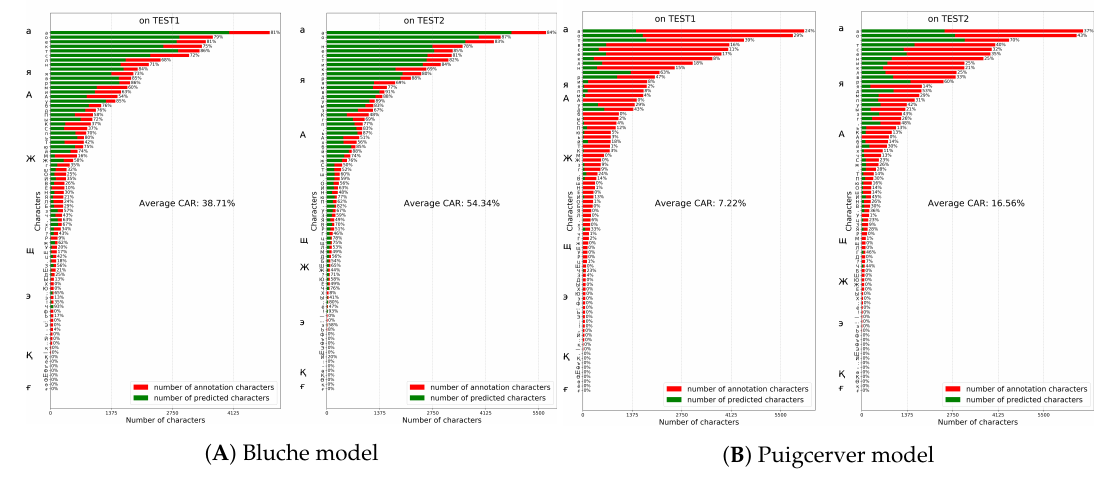
Figure 11. Bluche and Puigcerver models performance on TEST1 and TEST2